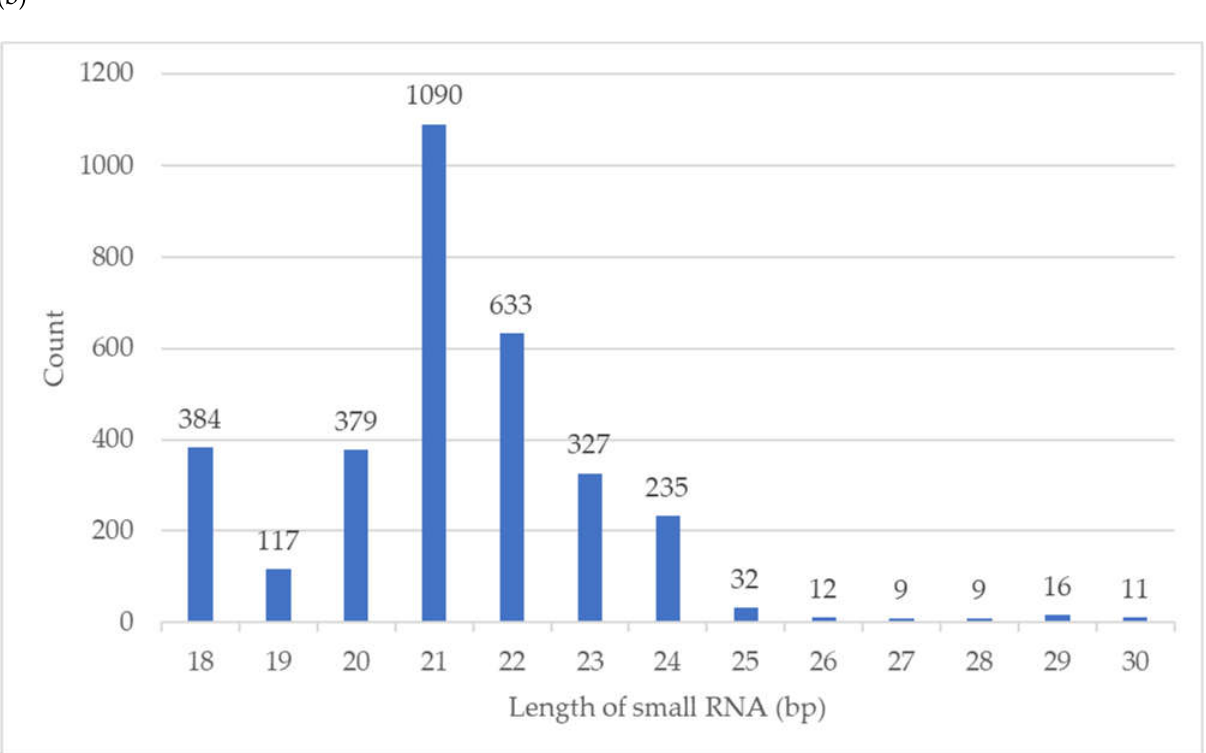
Figure 1. Size distribution of small RNA reads that mapped to the Ceratobasidium C02 genome assembly. ( a ) SRNA reads were trimmed of sequencing adapters, low quality bases, non-structure small RNAs removed, and reads of 18—30 nt selected for each of the six isogenic Ceratobasidium lines. Lines BCD2, BCD7 and BCD8 harboured three viruses, while lines FREE5, FREE6 and FREE8 were free of viruses ( b ) Size distribution of major small RNAs of 3272 small RNA loci, identified by ShortStack in the Ceratobasidium C02 genome assembly.